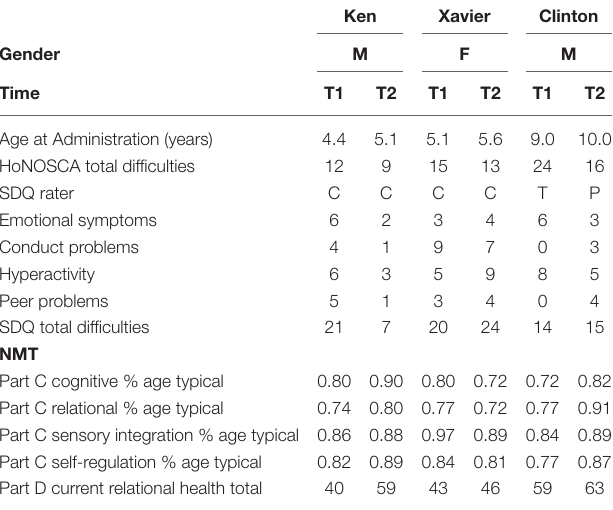
TABLE 11 | Case vignette summary of changes in clinical measures over time. Ken Xavier